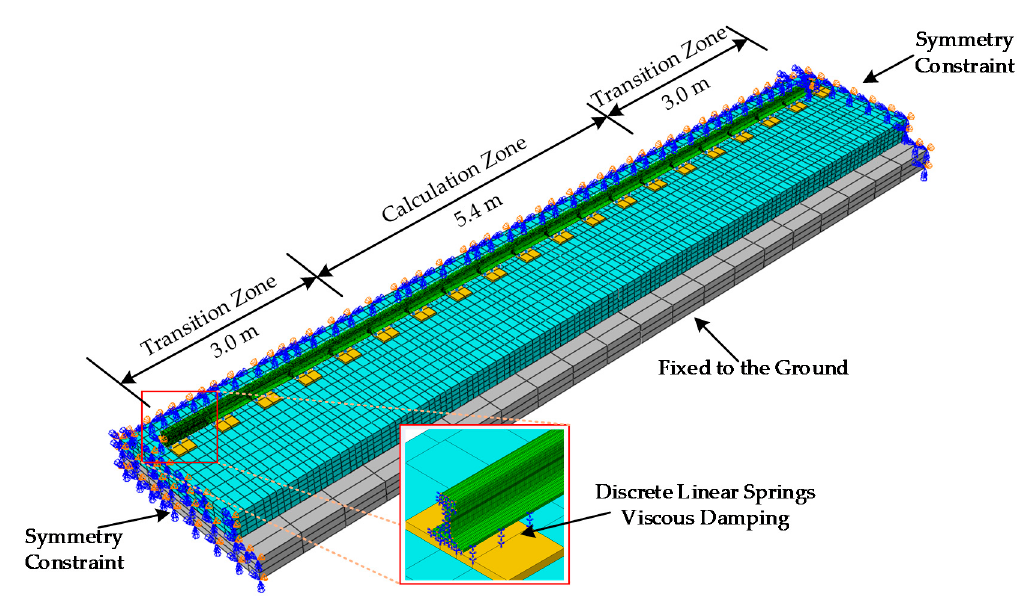
Figure 5. Refined rail responses simulation model.